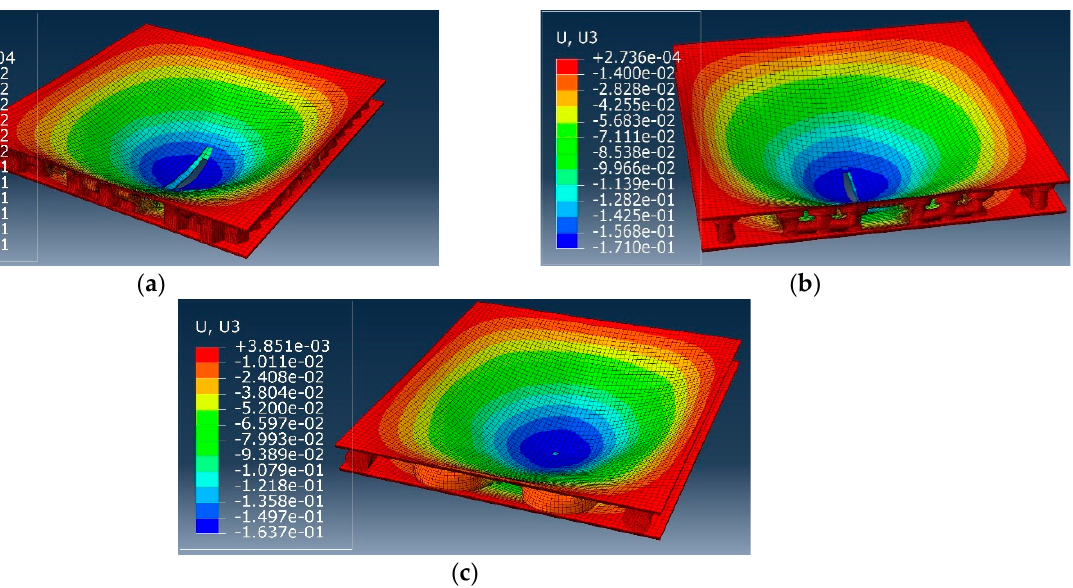
Figure 9. Deformation profile for sandwich panel with a façade plate thickness of 5 mm, core–core spacing of 112.5 mm, and ( a ) honeycomb ( b ) mushroom ( c ) tubular core shape. spacing of 112.5 mm, and ( a ) honeycomb ( b ) mushroom ( c ) tubular core